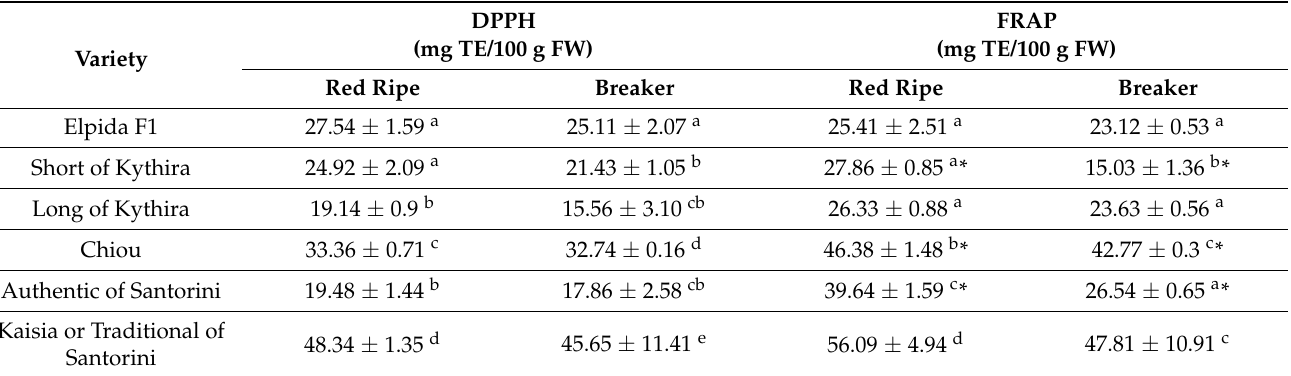
Table 4. Hydrophilic antioxidant activity (HAA) of tomatoes at red ripe and breaker ripening stage.